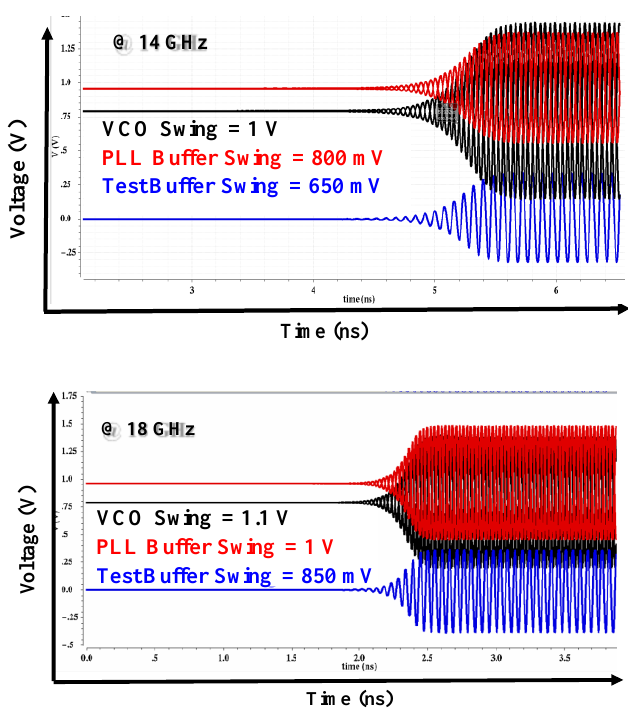
Figure 12. Transient simulation of the proposed VCO.